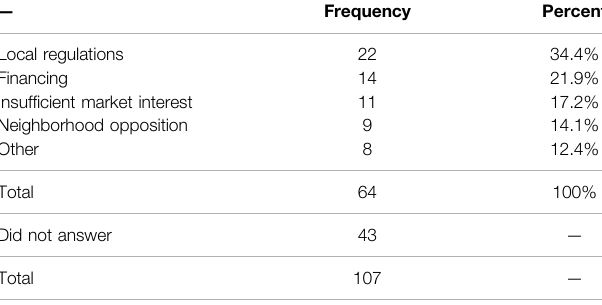
TABLE 10 | Current Frequency of most signi fi cant Challenge. —